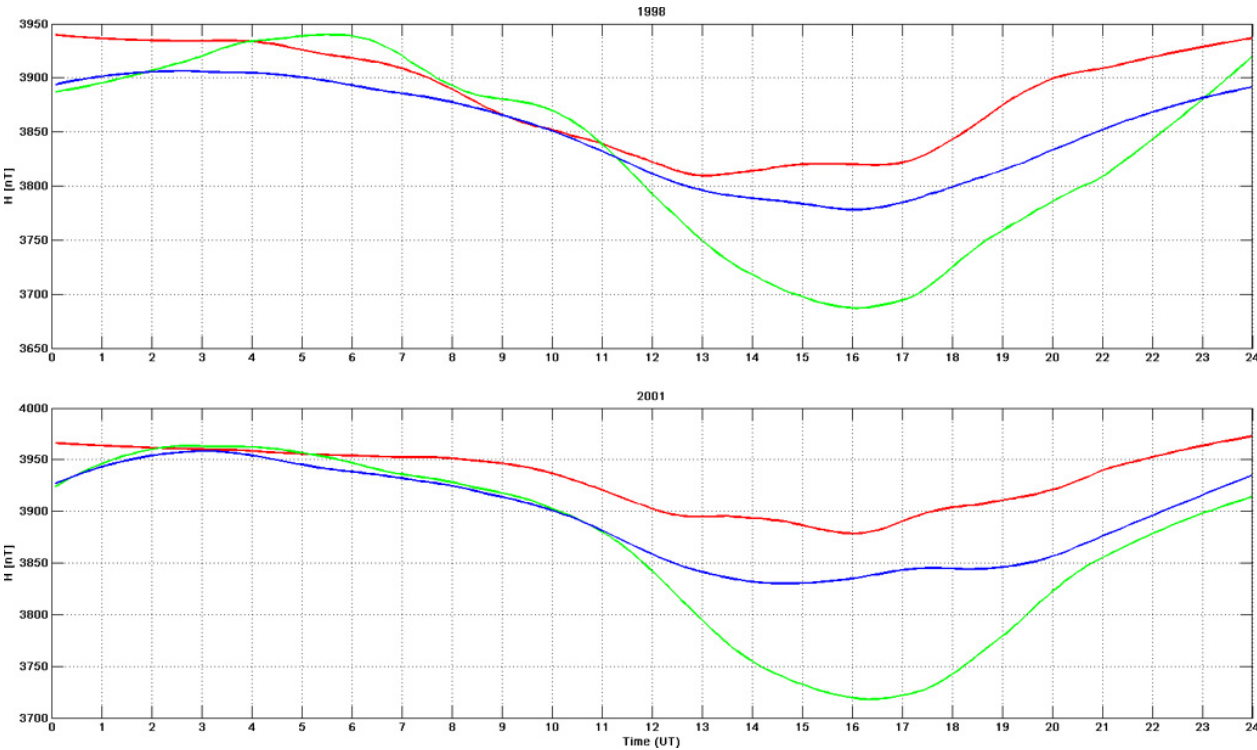
Fig. 5. The mean daily variation in H magnetic component at station Thule derived for three gradations of the IMF azimuthal component B y > 3nT (red line), B y < − 3nT (green line) and − 2 <B y < 2nT (blue line) for the summer months (May–August) of 1998 and